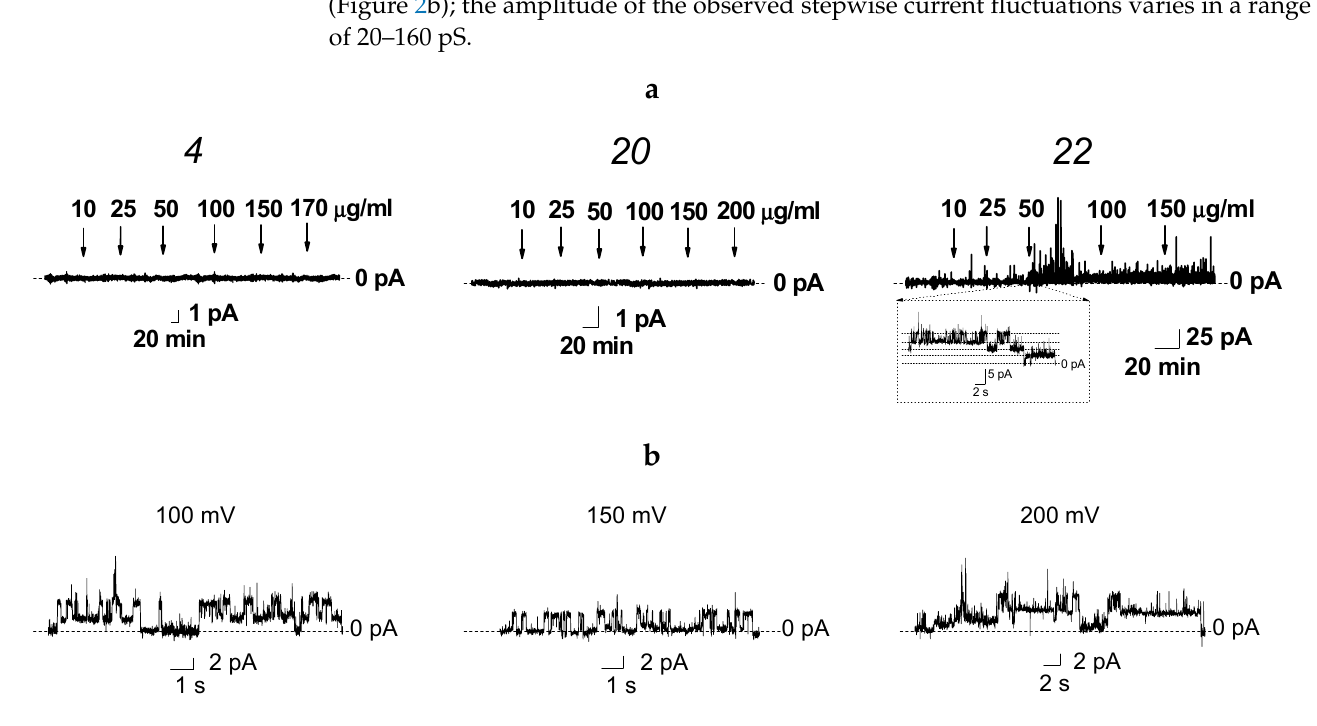
Figure 2. ( a ) The examples of time tracks of the transmembrane current ( I ) induced by compounds 4 , 20 , and 22 in DPhPG bilayers. The bilayers were bathed in 0.1 M KCl, pH 7.4. The transmembrane voltage was equal to 100 mV. The moments of addition of compounds 4 , 20 , and 22 are indicated by arrows. Above the arrows are the concentrations of the agents in the membrane bathing solution. Inset: Stepwise current fluctuations induced by compound 22 . ( b ) The examples of current fluctuations corresponding to openings and closures of single transient pores induced by compound 22 in DPhPG bilayers at different transmembrane voltages (100, 150, and 200 mV). Membranes were bathed in 0.1 M KCl, 5 mM HEPES, pH 7.4. The derivative concentration in bilayer bathing solution was equal to 50 μ g/mL.